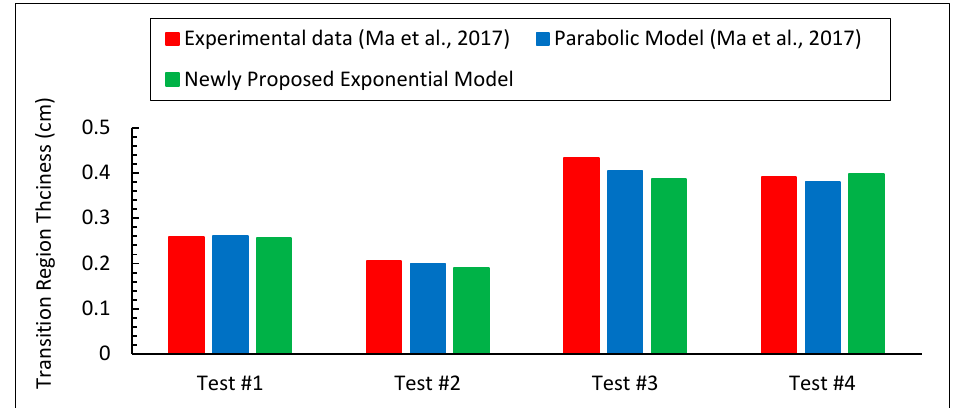
Figure 20. Comparison of the average transition region thickness values [3].